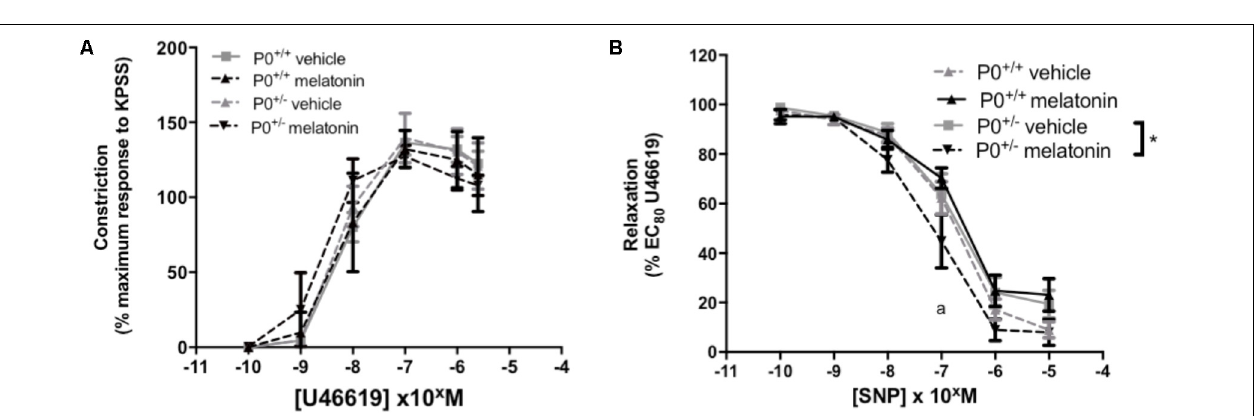
FIGURE 5 | Constriction and relaxation responses of umbilical arteries from P0 + / + and P0 + / - mice at embryonic day 18.5. (A) Dose-dependent constriction to 10 - 10 to 2 × 10 - 6 M U46619 shown as a percentage of the maximum constriction to KPSS. (B) Dose dependent relaxation to sodium nitroprusside (SNP) is shown as a percentage of EC 80 U46619 constriction. Data are presented as mean ± SEM. N’s as follows ( N = litters, n = pups); P0 + / + vehicle N = 7, n = 12, P0 + / + melatonin N = 7, n = 12, P0 + / - vehicle N = 7, n = 12, P0 + / - melatonin N = 7, n = 9. Statistical analysis was carried out by two-way ANOVA to assess the effect of genotype and treatment with Bonferroni post-test to compare individual groups. ∗ P < 0.05. a P < 0.05 P0 + / - melatonin vs. P0 + / + vehicle and P0 + / + melatonin at 10 - 7